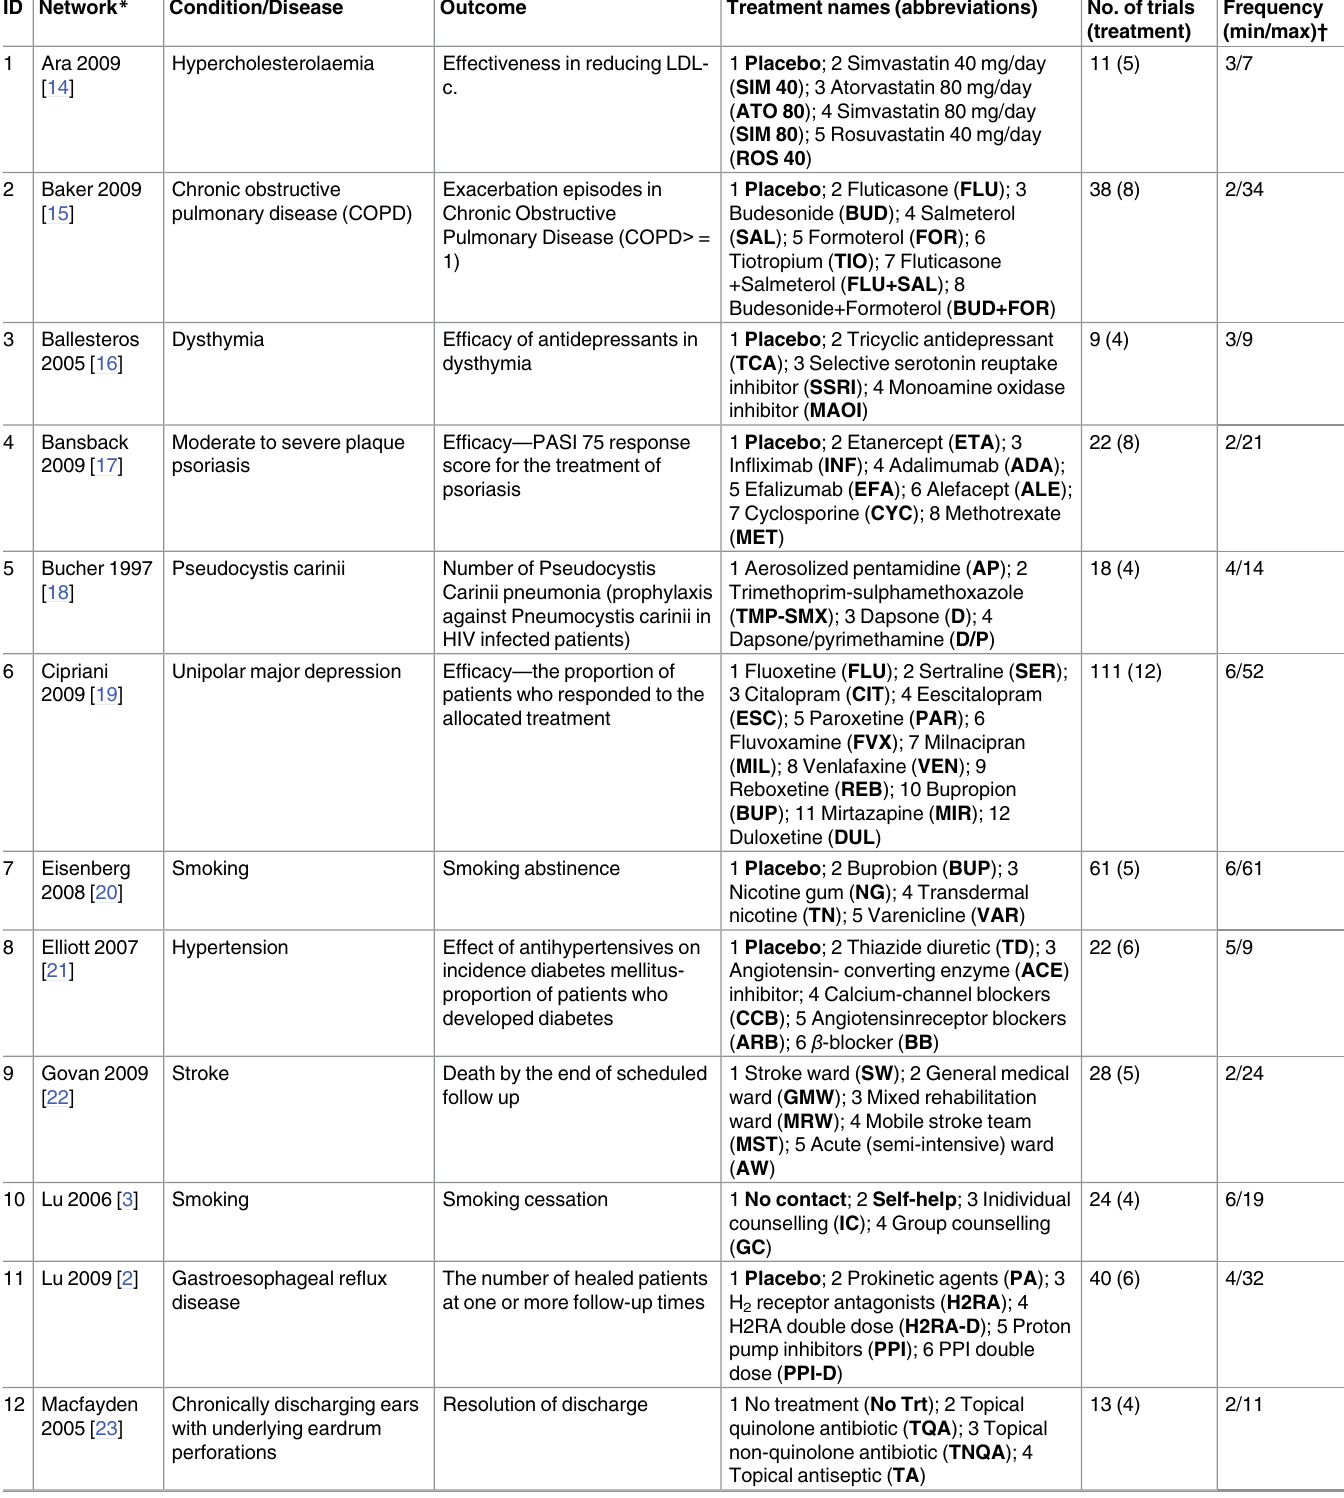
Table 1. Characteristics of the 20 network